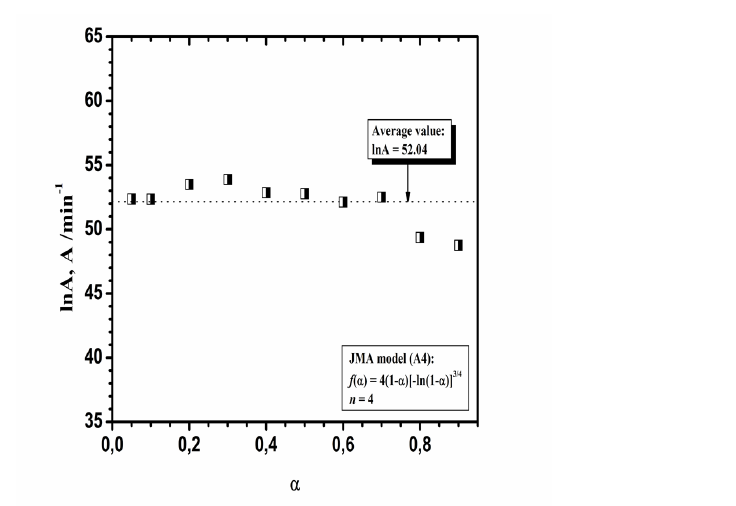
Figure 7 – The logarithm of the pre-exponential factor (lnA) calculated from the differential (Friedman) isoconversional method as a function of the fractional conversion ( α ) for function f( α ) = 4(1 - α )[- ln(1 – α )] 3/4 (n = 4.0), in the case of the crystallization process of the amorphous Fe 81 B 13 Si 4 C 2 alloy (the dot line represents the average value of lnA) Slika 7 – Logaritam predeksponencijalnog faktora (lnA) izra č unat iz diferencijalne (Fridman) izokonverzione metode u funkciji konverzione frakcije ( α ) za funkciju f( α ) = 4(1 - α )[- ln(1 – α )] 3/4 (n = 4.0), u slu č aju procesa kristalizacije amorfne Fe 81 B 13 Si 4 C 2 legure (ta č kasta linija predstavlja srednju vrednost